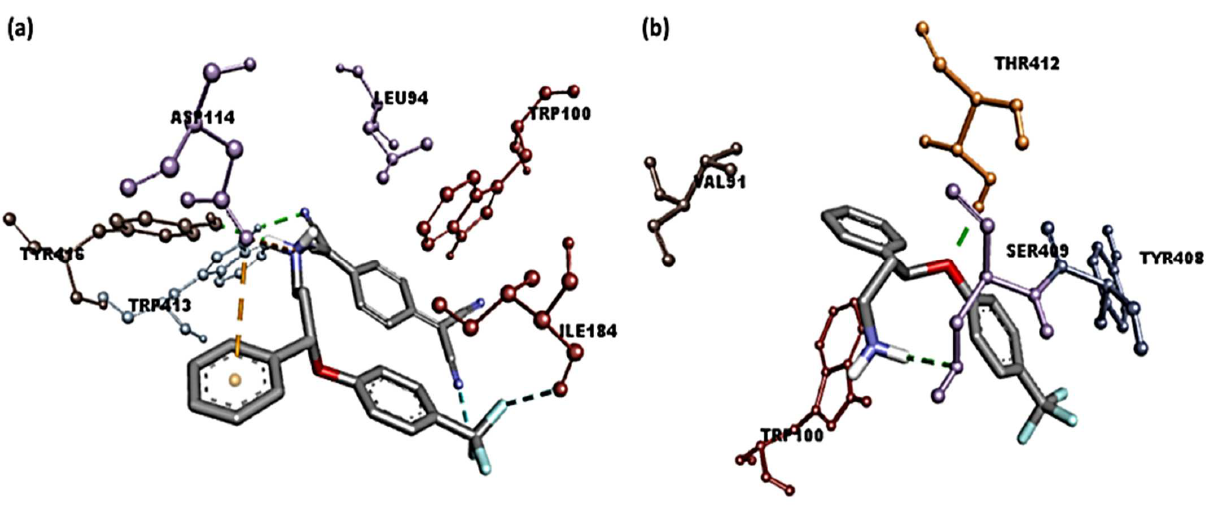
Figure 8. Three-dimesnional representation of interactions for dopamine docked with ( a ) [(SRX)(TCNQ)] and ( b ) [SRX]. and ( b )